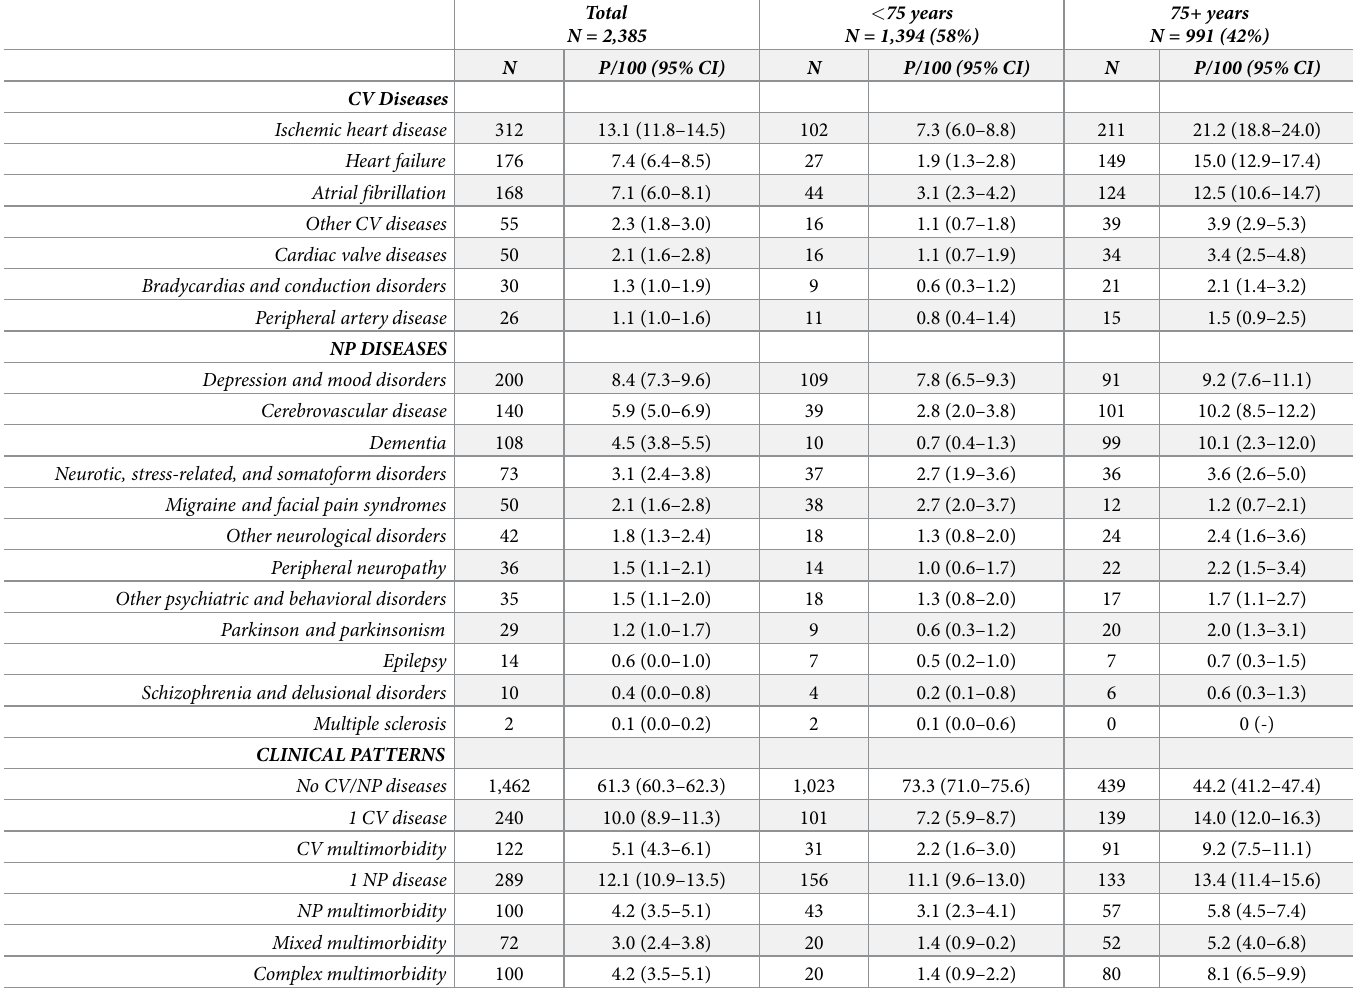
Table 2. P/100 of CV and NP chronic diseases (cid:3) and clinical patterns at